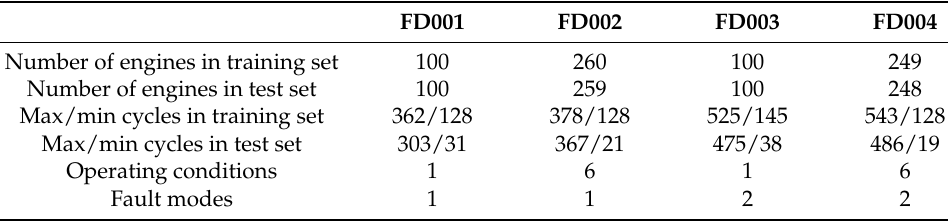
Table 1. CMAPSS dataset